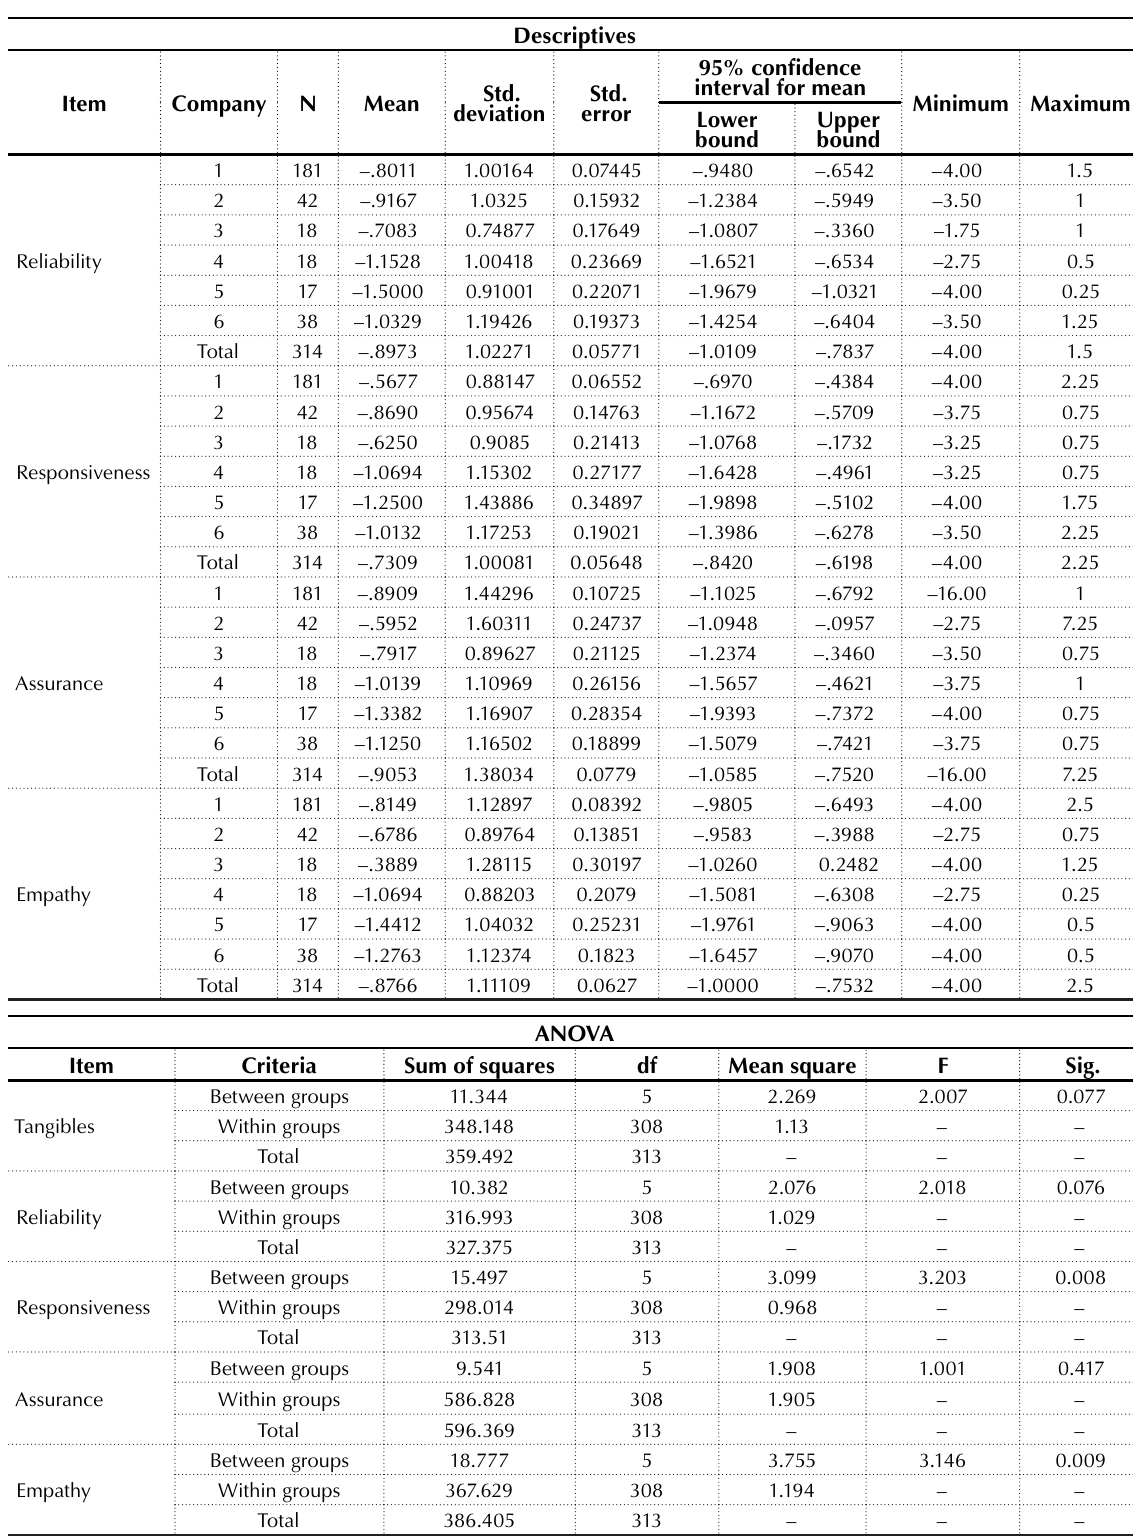
Table A6 (cont.). Company and gap scores of individual SERVQUAL